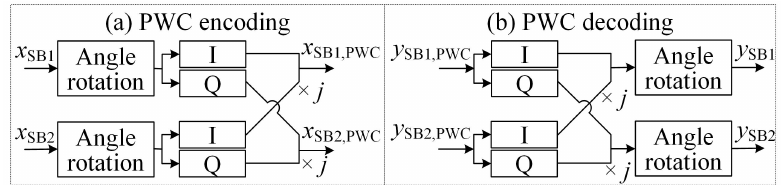
Figure 2. Schematic diagrams of ( a ) PWC encoding and ( b ) PWC decoding.